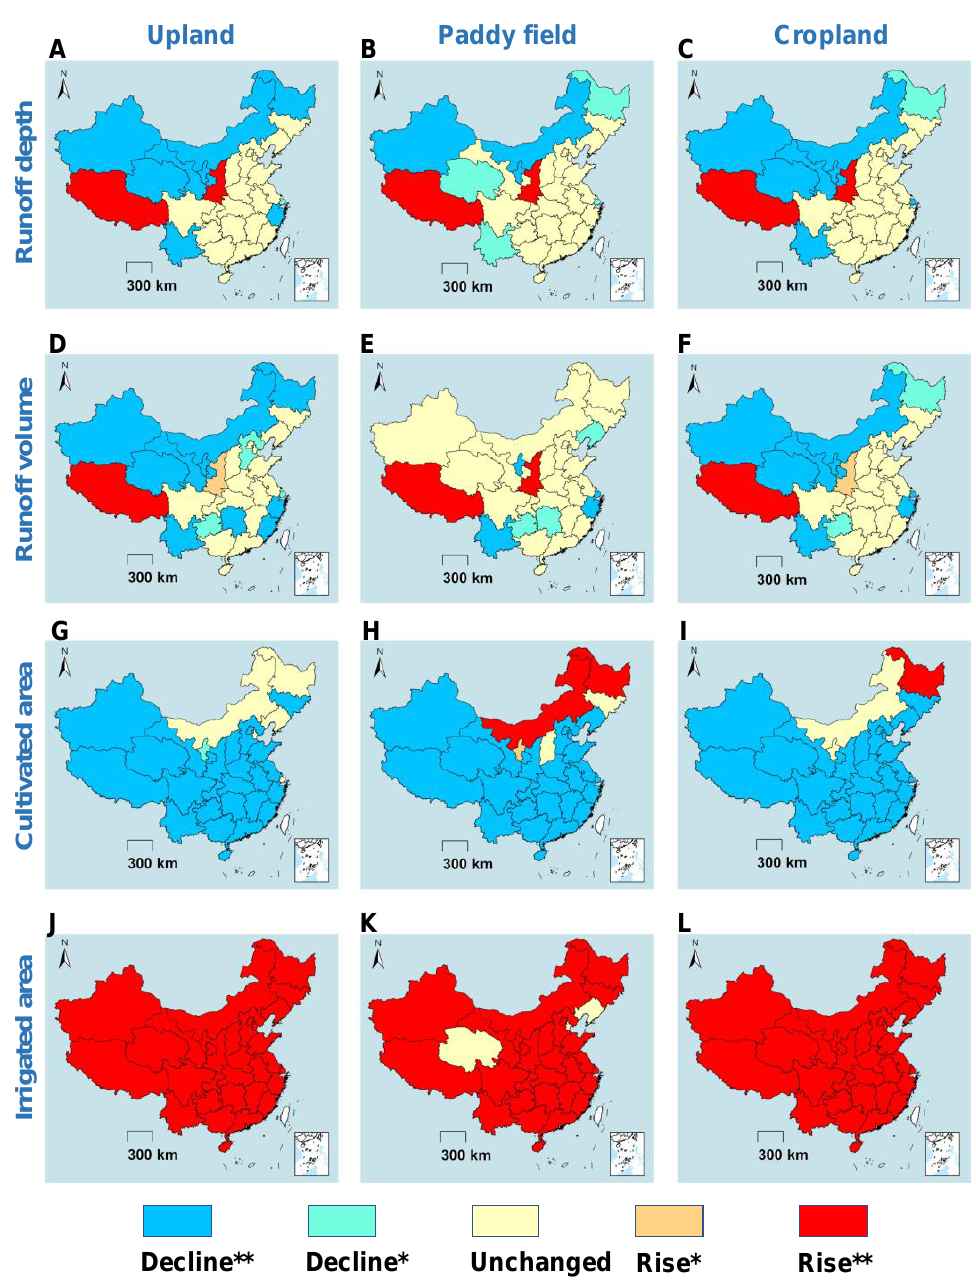
Figure 6. Temporal trends of annual ( A – C ) cropland runoff depth, ( D – F ) cropland runoff volume, ( G – H ) cultivated area and ( J – L ) irrigated area from 1990 to 2013. Unchanged indicated by p > 0.05, * indicates p < 0.05, ** indicates p < 0.01. The smaller map frame of each figure at the lower right corner represents the ten-dash line of Nansha Islands.